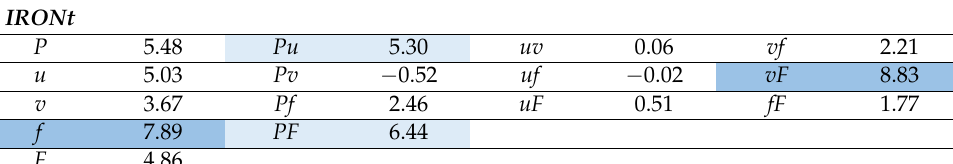
Figure 7. Faceted boxplots of ICYLt data according to experimental factors ( A ) boxes by laser power P and laser scan speed u , ( B ) boxes by burnishing feed f , burnishing speed v , and burnishing force F. Table 4. Main effects and interactions of experimental factors regarding the improvement ratio of roundness total ( IRONt